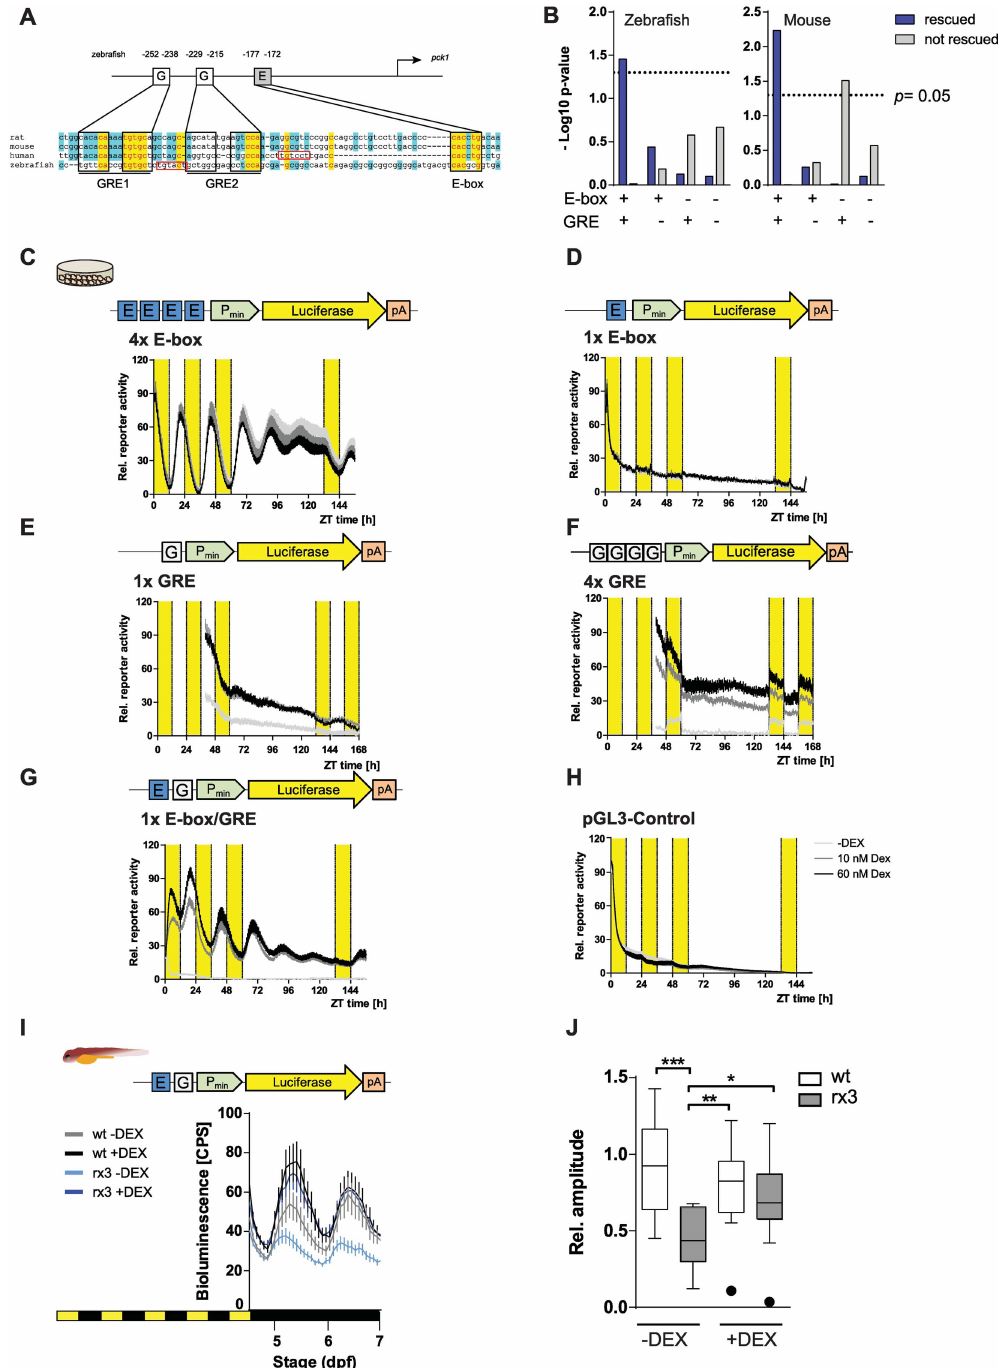
Fig 5. A module of E-box and GRE elements drives circadian expression under constant DEX treatment in vitro and in vivo . (A) Multiple alignment of the pck1 promoters of the indicatedspecies. Red boxes indicate GRE half sites. (B) Graph depictingp values for observed vs. randomoccurrence of E-boxes and GREs in the promoter regions of model 5-6-14-15genes rescued(green) or not rescued(red) by DEX treatment. (C-H) Bioluminescence traces recordedfrom zebrafishcells expressingthe indicatedreporter constructs under different doses of DEX. G, GRE. E, E-box. P min ,TATA box. pA, polyadenylation site. (I) In vivo bioluminescence traces recordedfrom transgenic zebrafishlarvae carrying the 1xE-box/GRE reporter in the indicatedphenotype/treatment combinations. (J) Boxplots depictingamplitudes of the bioluminescence oscillations shown in D. * , p < 0.05, ** , p < 0.01, *** , p <